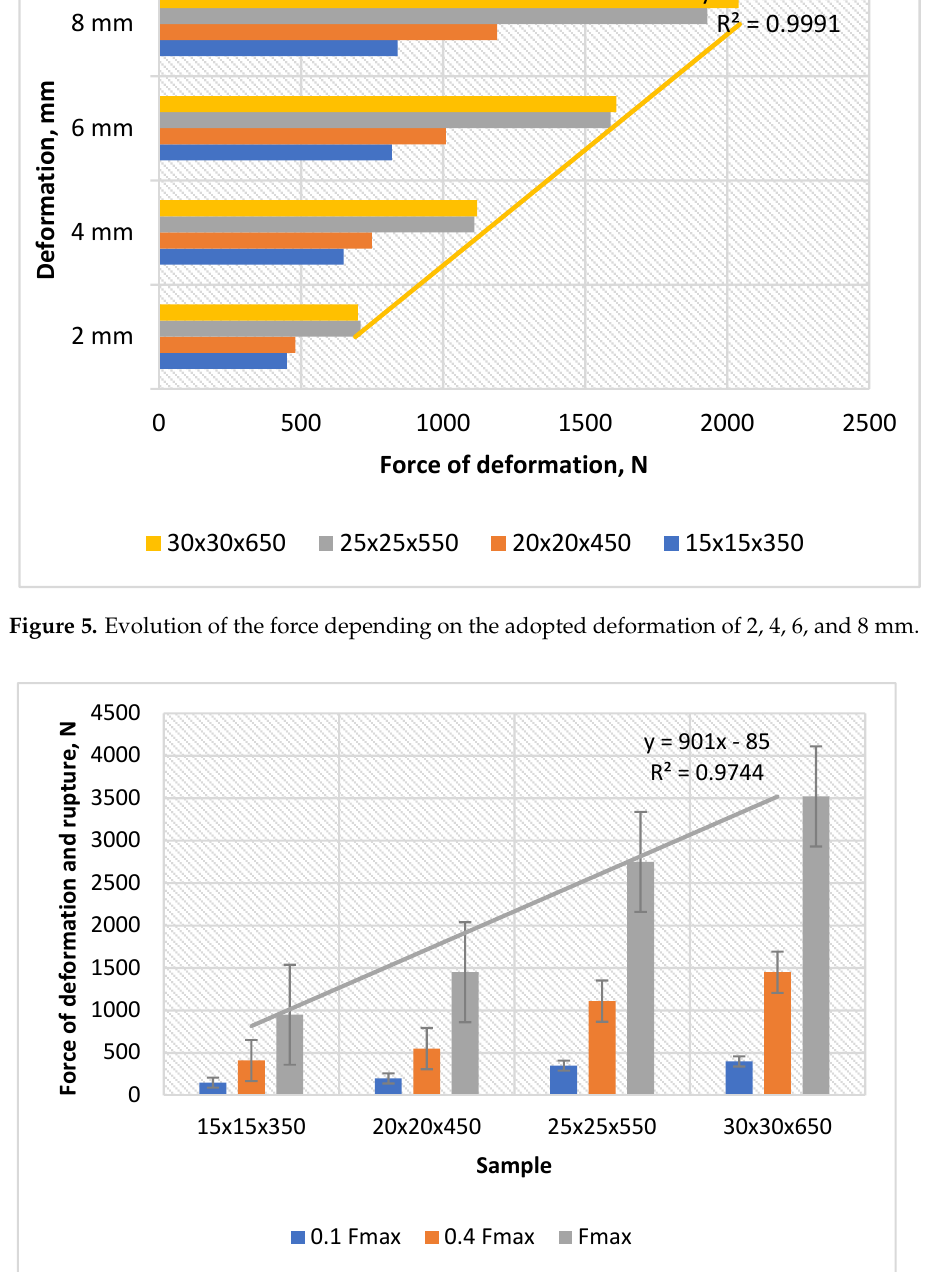
Figure 7. Influence of the width and thickness of the specimen on the modulus of elasticity. Since the modulus of elasticity is maximum for thicknesses of 15 and 20 mm, for technological reasons (easy processing and more rigidity), the thickness of 20 mm was chosen. Based on the results obtained after testing deformation for elasticity by bending, the optimal dimensions used to make the test panels were established, from this point of view, the friezes with dimensions of 500 mm× 50 mm were found as optimal. 3.2. Choosing the Optimal Parquet Structure Depending on the Ricochet of the Ball The four types of floor structures considered had different results. First of all, the influence of the inflation pressure of the basketball on the response when it touches the reinforced concrete surface with an equalizing slab was analyzed. Figure 8 shows the maximum bounce of the inflated ball with three different pressures compared to the average of the five measurements with the value provided in the standard.